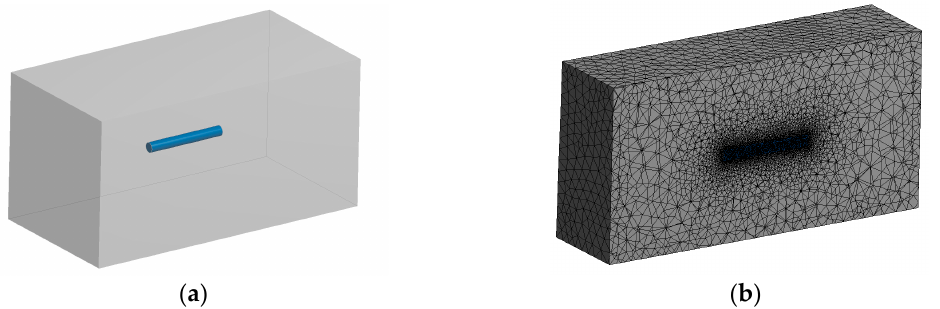
Figure 4. Model of equivalent inclusion problem for cylindrical fiber: ( a ) geometry; ( b ) finite element mesh.